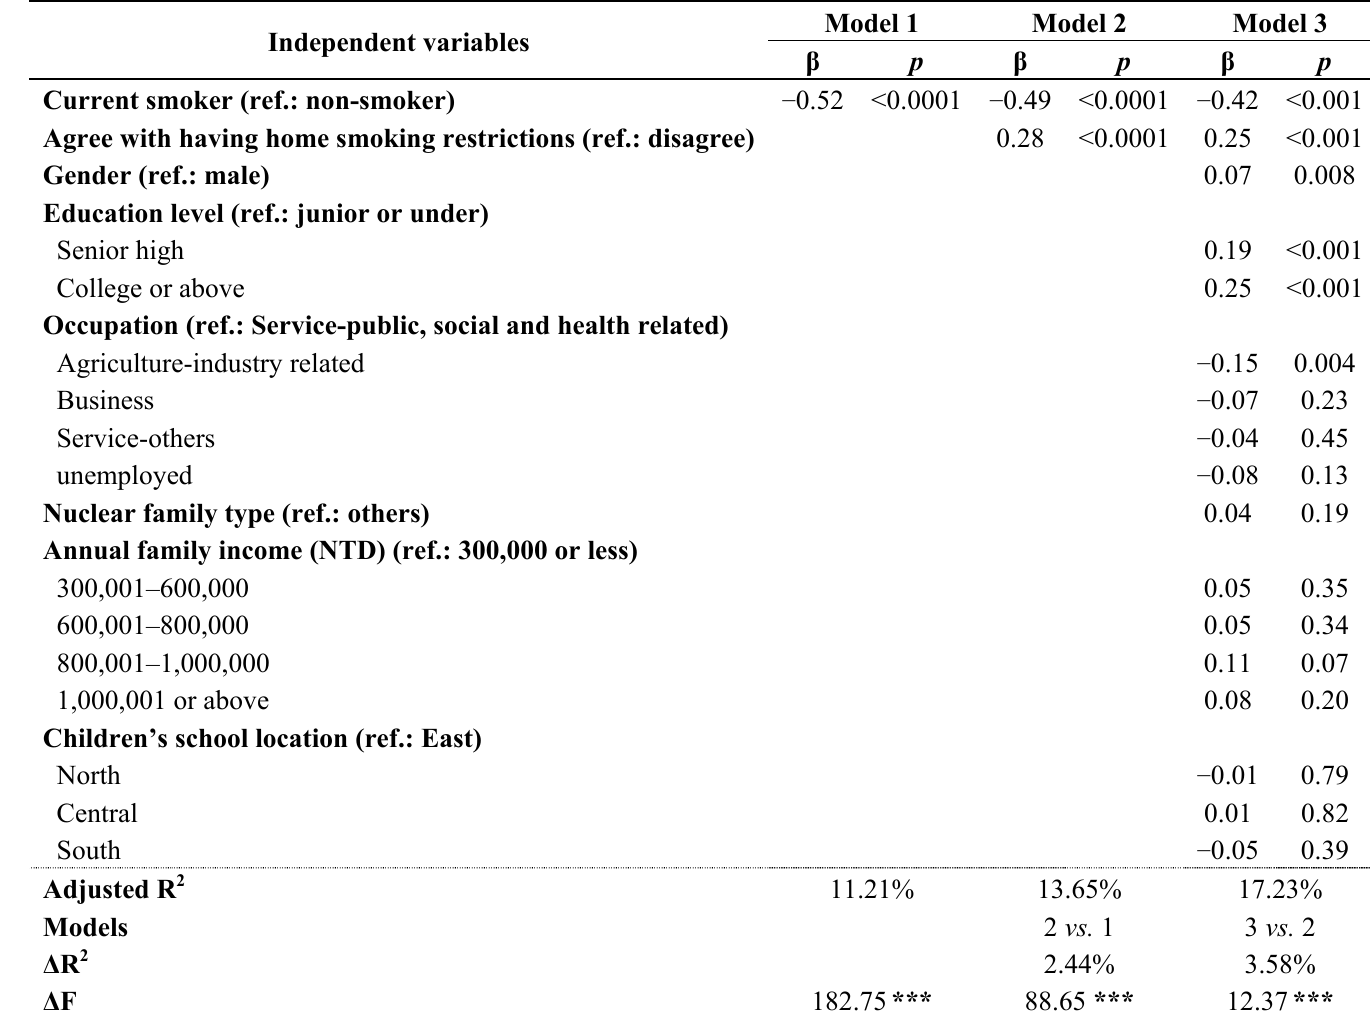
Table 3. Hierarchical Regression Analysis for factors predicting parents’ evaluation of the consequences of parental smoking in the presence of